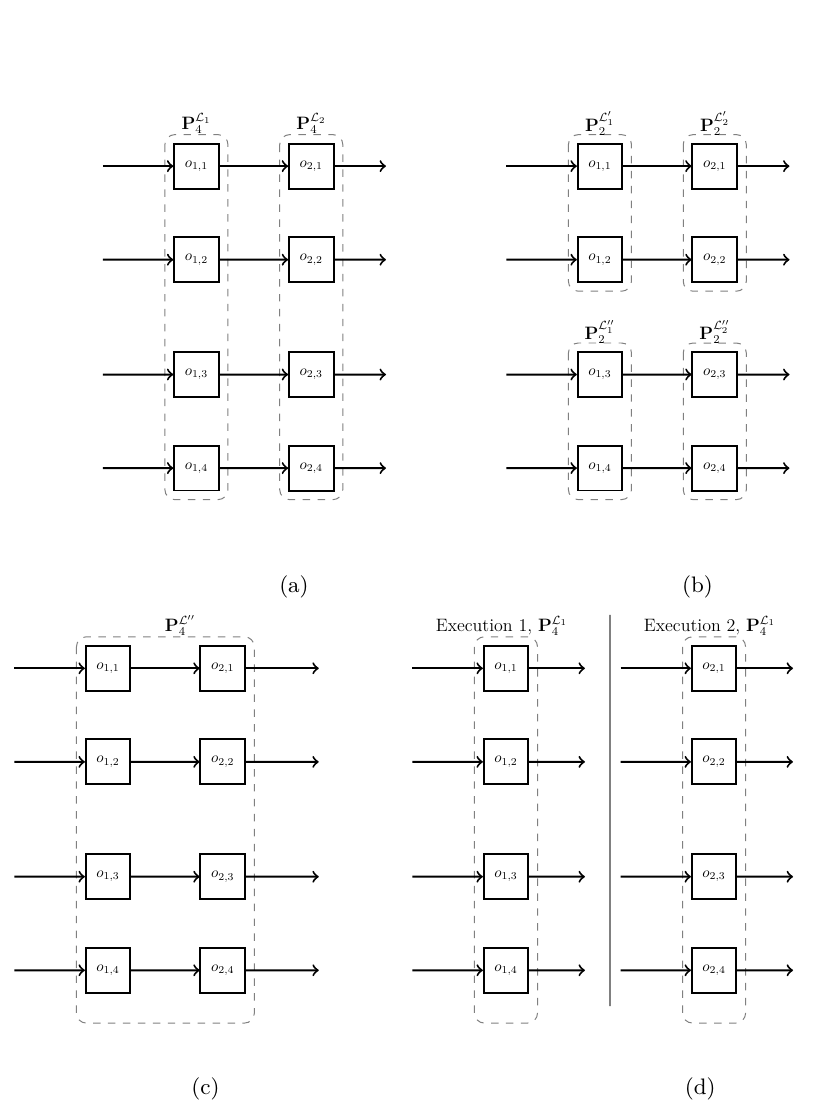
Figure 7: Initial, partitioned, merged and recycled shuffle is applied to the layered cipher structure in Figures (a) - (d). Dashed-line boxes indicate the operations and layers that are shuffled with the same permutation. The arrows indicate the information flow between